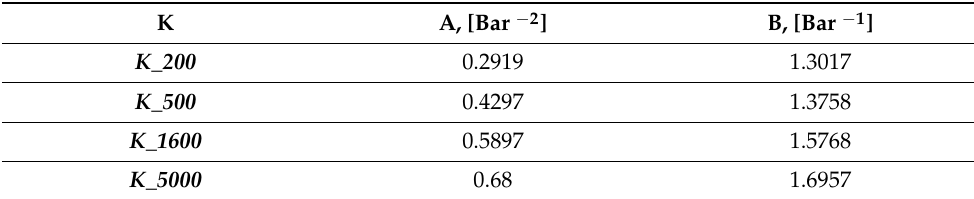
Table 3. Polynomial coefficients in Equation (4), for calculation of compensation factor for the four reference concentrations.